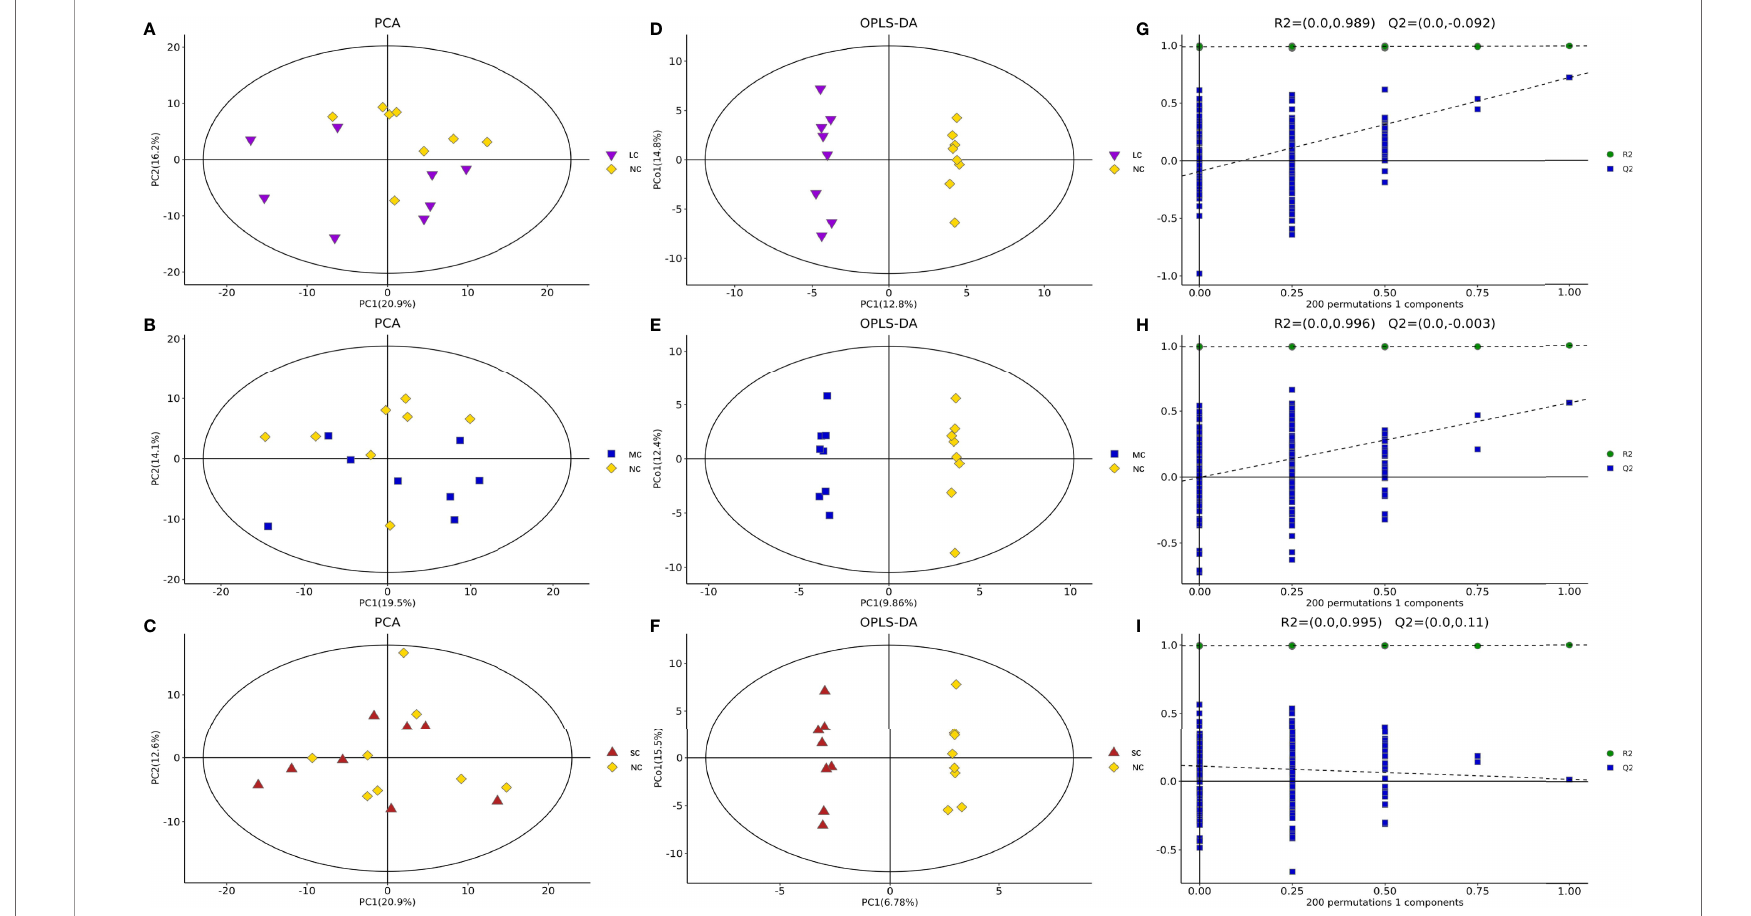
FIGURE 1 | The PCA scores plots, OPLS-DA scores plots and response permutation testing plots for different salinity groups of P. trituberculatus . PCA score plot of LCvsNC (A) , MCvsNC (B) and SCvsNC (C) ; OPLS-DA scores plots of LCvsNC (D) , MCvsNC (E) and SCvsNC (F) ; response permutation testing plots of LCvsNC (G) , MCvsNC (H) and SCvsNC (I)